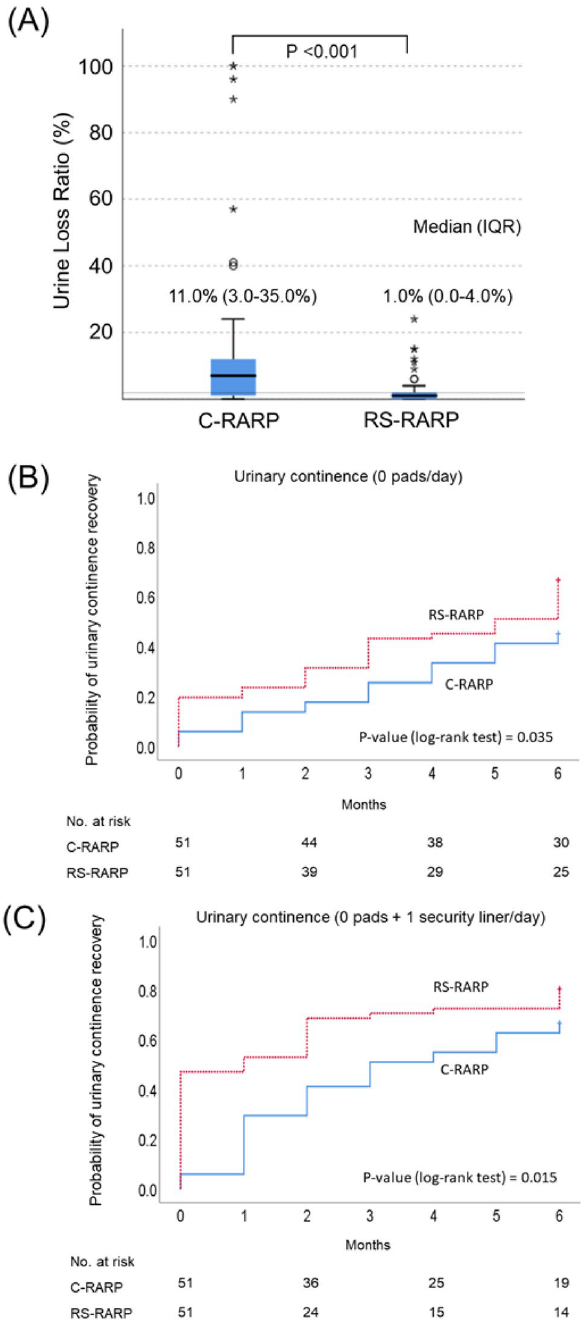
Figure 4. Comparison between conventional and Retzius-sparing robot-assisted radical prostatectomy for urine loss ratio immediately after catheter removal ( A ). Kaplan–Meier curves show the recovery of urinary continence (defined as ( B ) 0 pads/day and ( C ) 0 pads + one security liner/day) between the